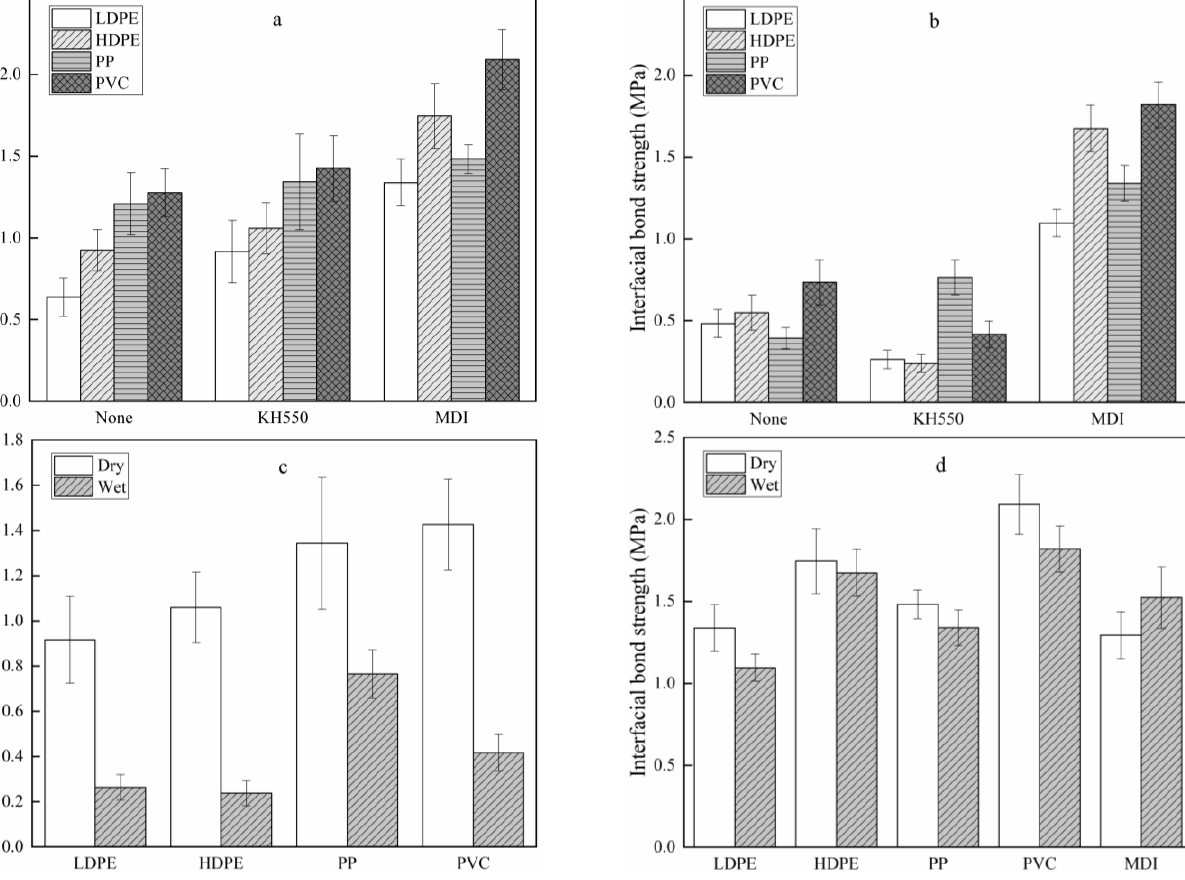
Figure 2. Interfacial bond strength of VPC under: ( a ) dry conditions; ( b ) wet conditions. The interfacial bond strength of VPC with the coupling agent: ( c ) KH550; ( d ) MDI.